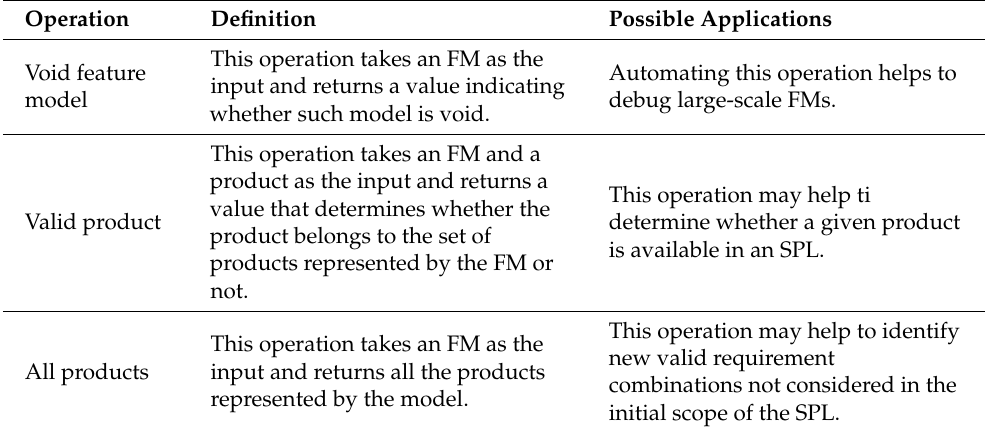
Table 2. Examples of analysis operations on FMs.